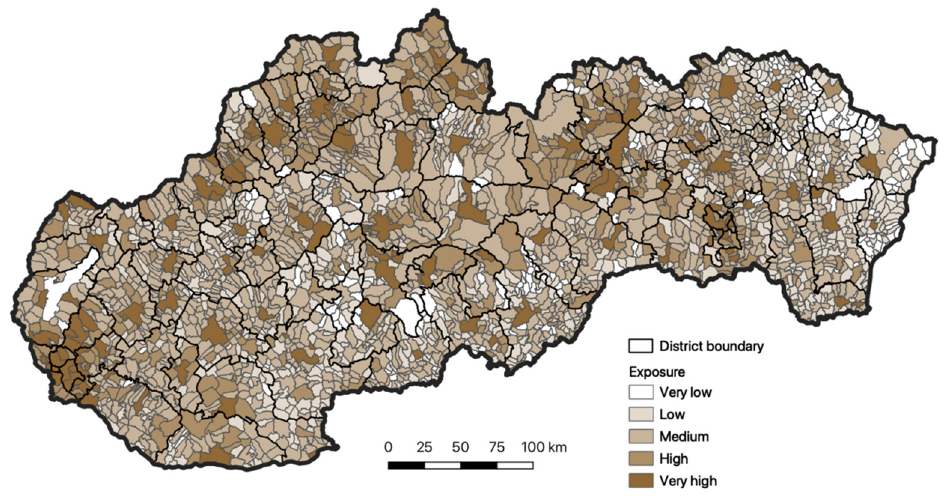
Figure 5. Exposure of inhabitants of Slovakia to respiratory diseases. Source: Statistical Office of the Slovak Republic, 2020.